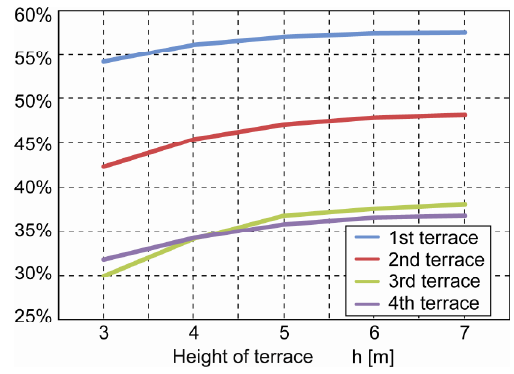
Fig. 24. Trend of change of effect of cutting width